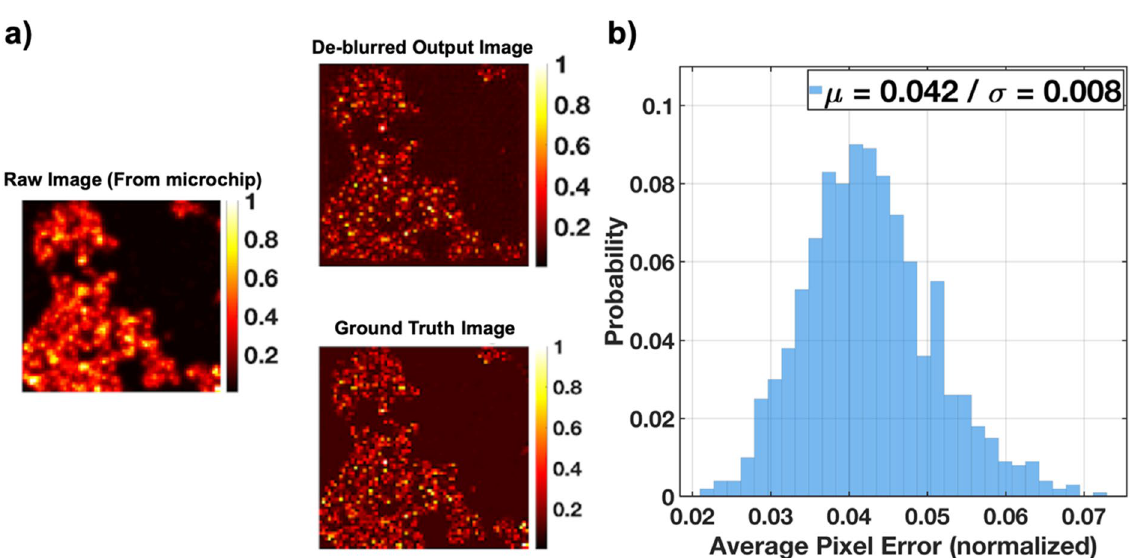
Figure 3. Performance of the deblurring module: ( a ) Network input and output images for a test sample in comparison with the corresponding ground truth image. ( b ) Distribution of average pixel error for 1000 test samples with a mean error of